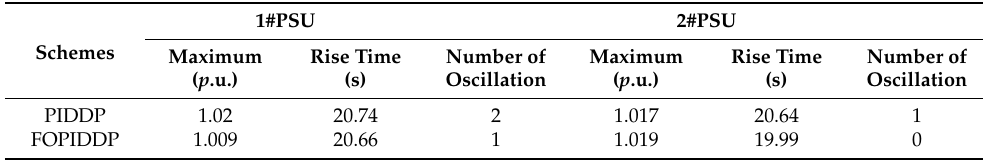
Figure 18. Start-up process curves in the full-characteristic curve of the 2# PSU. The maximum and the rise time of the rotational speed were recorded, and the oscillation number of the rotational speed of the four schemes is shown in Table 5. Table 5. The quantitative index of the rotational speed.